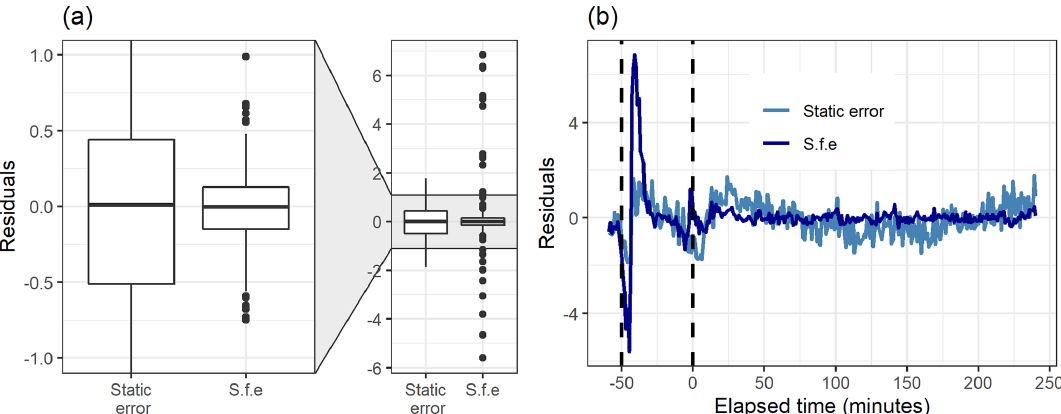
Figure 8. Boxplot (a) and the time series (b) of the residuals (original total signal – reconstructed total signal) with static error and signal following error (S.f.e) with five factors from PMF for the measured gas-phase (PTR-MS)